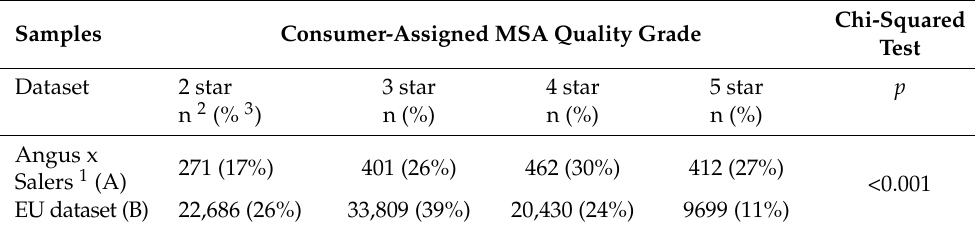
Table 5. Distribution of beef samples to different MSA quality grades by consumers based on the present database versus the European database utilized.